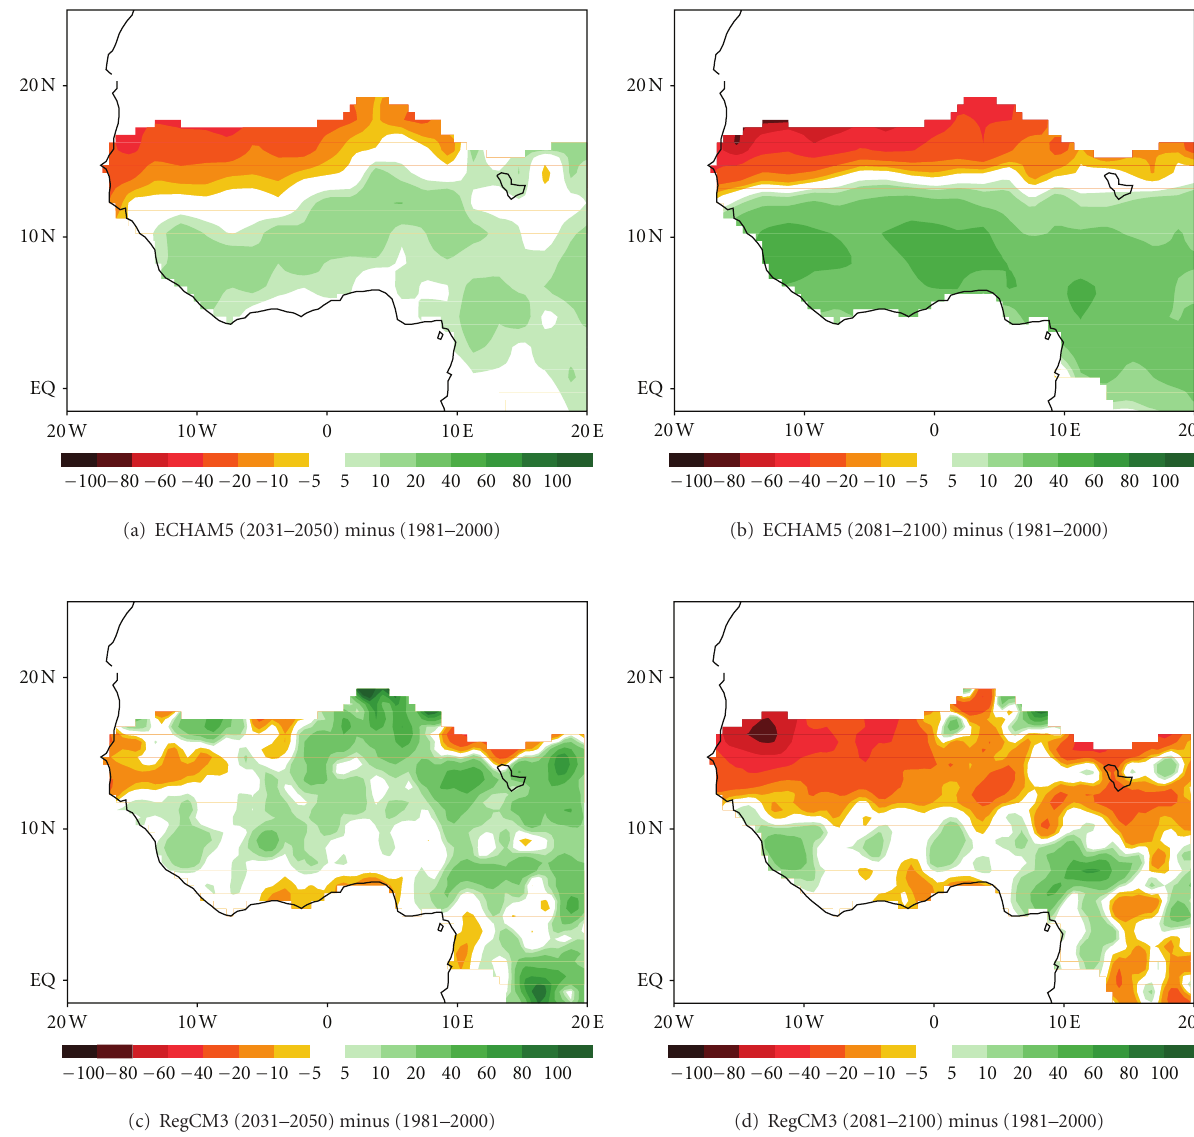
Figure 8: The same as Figure 7 but for the 95th